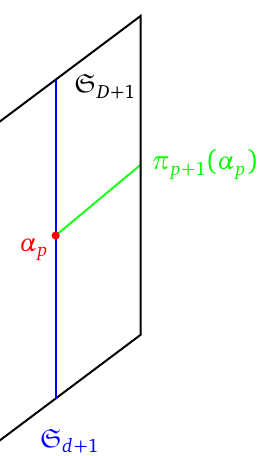
∈ L of the topological defect S p d , p + 1 ( α ) ∈ L of the TQFT S p + 1 p D , p + 2